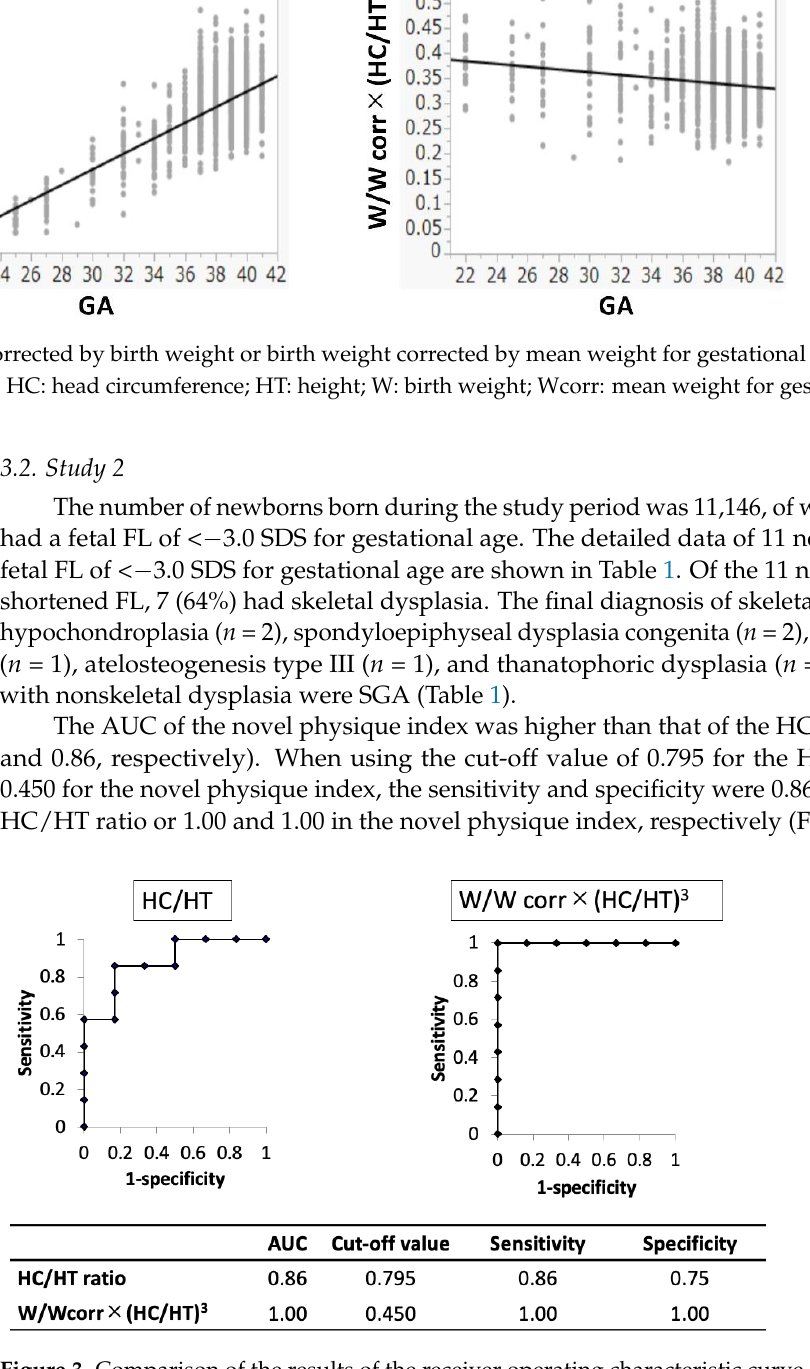
Figure 3. Comparison of the results of the receiver operating characteristic curve analysis between head circumference/height ratio and the novel physique index in cases with shortening of limbs in utero. AUC, area under the curve; HC, head circumference; HT, height; W, birth weight; Wcorr, mean weight for gestational age at birth.